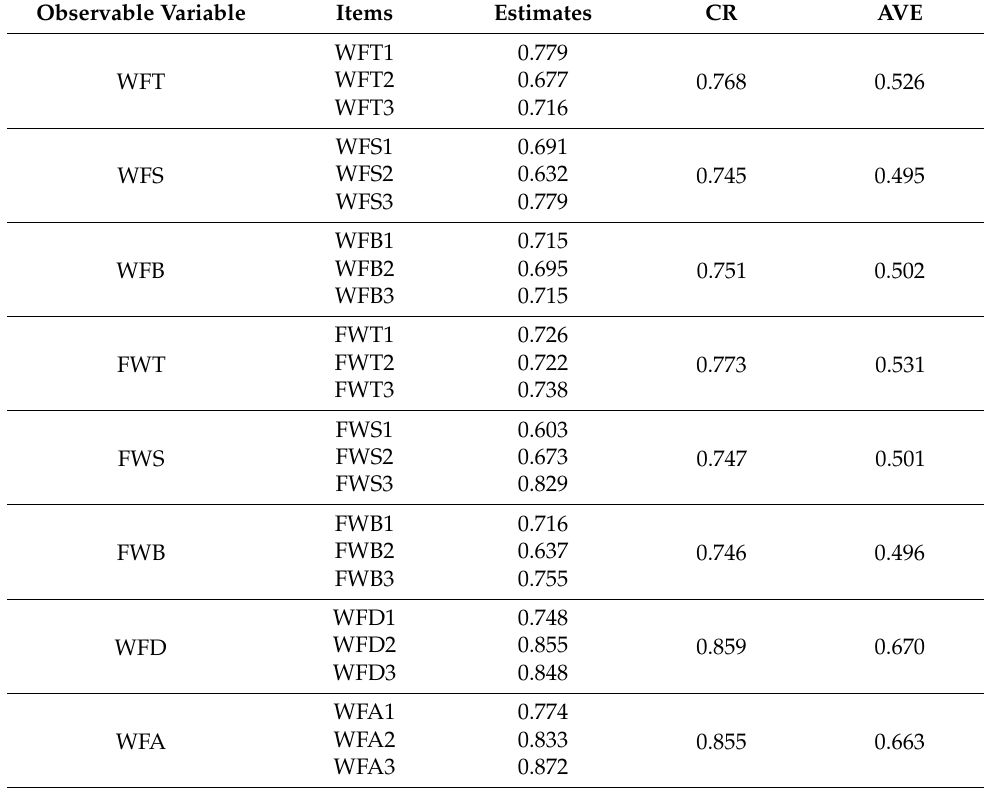
Table 5. Convergent